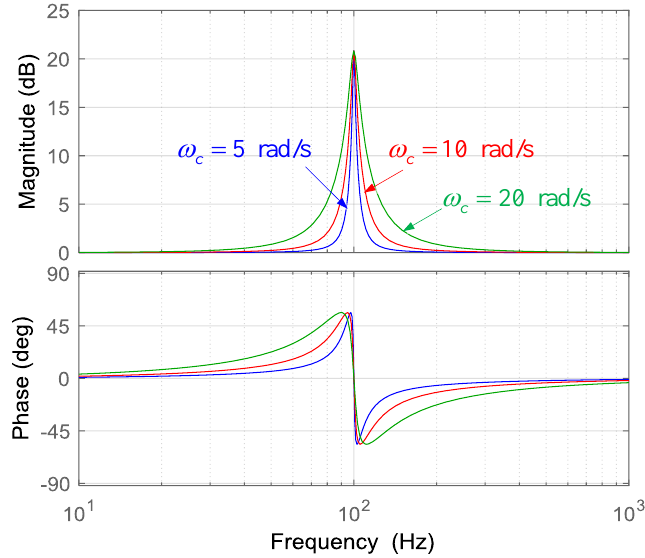
Figure 10. The bode diagram of the non-ideal PR controller.